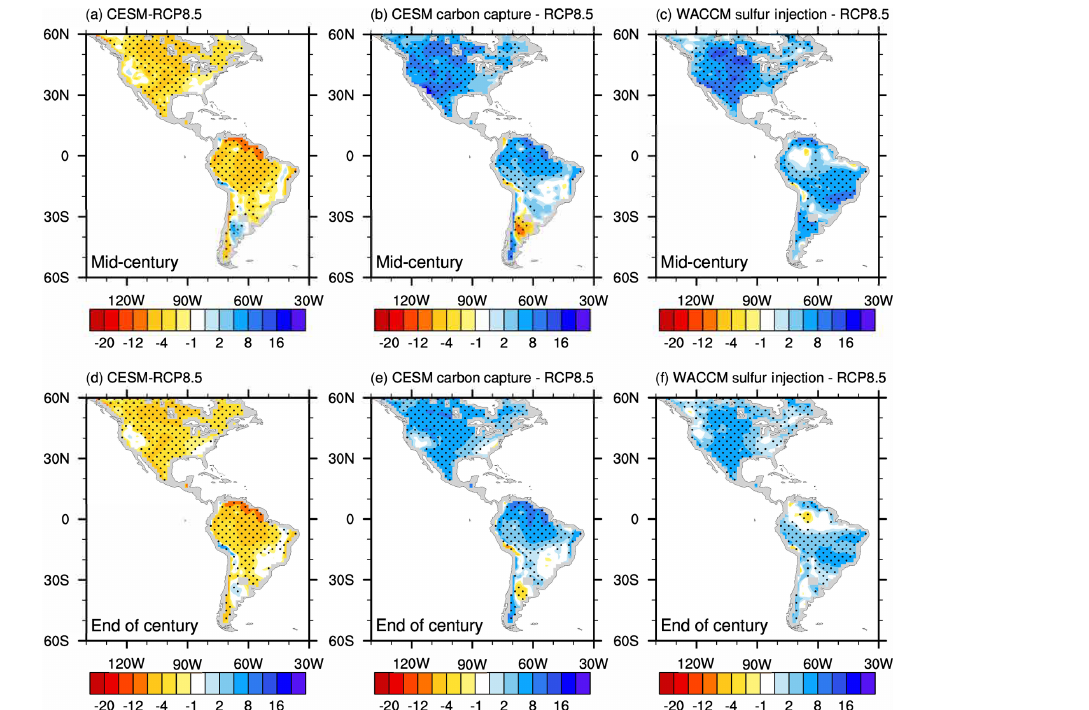
Figure 8. Similar to Fig. 5c–f but showing normalized P / PET change in percent per degree Celsius (% ◦ C − 1 ). Panels (a–c) show mid- century changes, and panels (d–f) represent end-of-century changes. The normalization is by scaling the global temperature change in (a, b, d, e) , for example 4.2 ◦ C due to carbon capture in panel (e) and 6.0 ◦ C due to sulfur injection in panel (f)